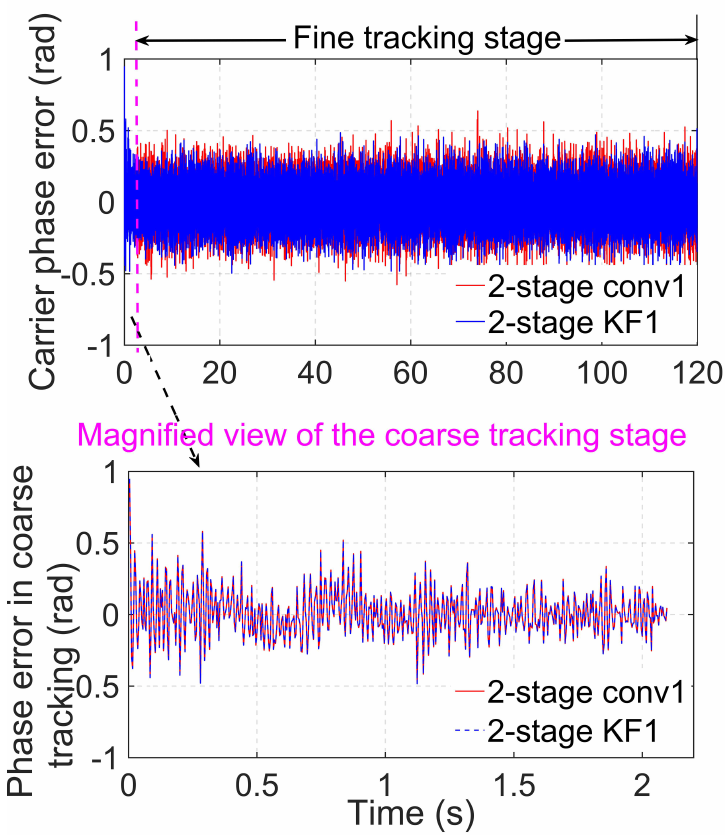
Figure 6. Carrier phase error of the algorithms, 2-stage conv1 and 2-stage KF1, when C/ N 0 = 39